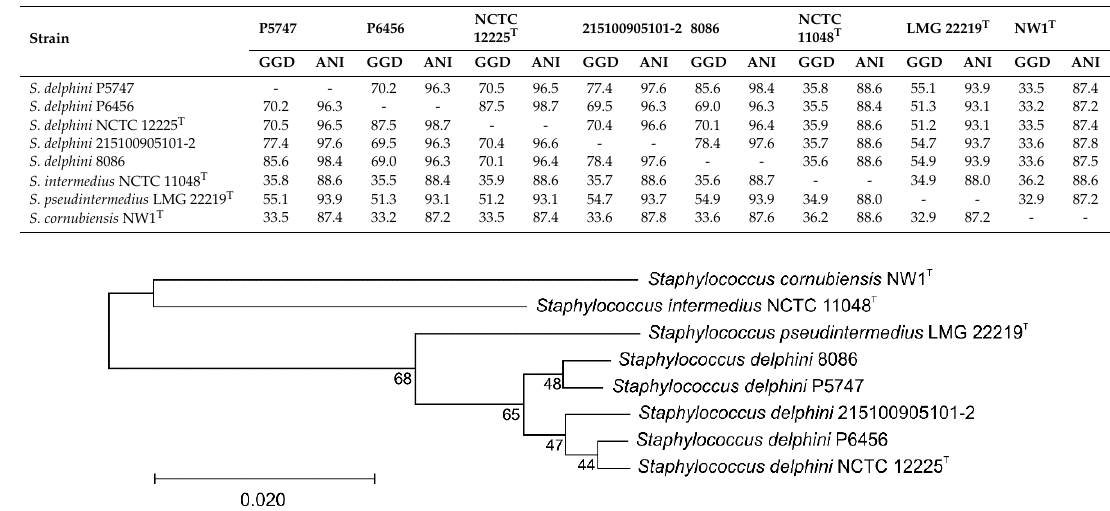
Figure 6. Core gene set phylogenetic tree of Staphylococcus delphini strains from different animals (penguin isolates P5747 and P6456, horse strains 8086 and 215100905101-2, and a dolphin strain NCTC 12225 T ). The phylogenetic tree was constructed using Up-to-date bacterial core gene set (UBCG) concatenated alignment of 92 core genes. A total of 86,031 nucleotide positions were used. Maximum likelihood phylogenetic tree was inferred using Fasttree version 2.1.10 using GTR + CAT model. Gene support indices are given at branching points (maximal possible value is 92). Bar, 0.1 substitution per position.